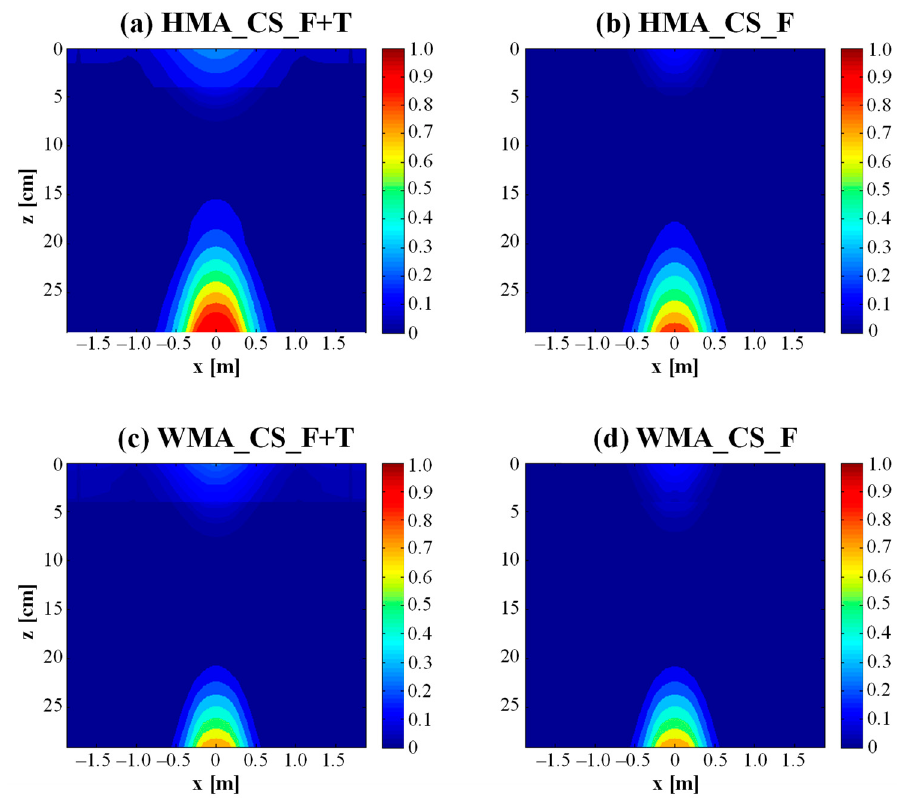
Figure 8. Damage contours in the case of cracked subbase after 30 years.